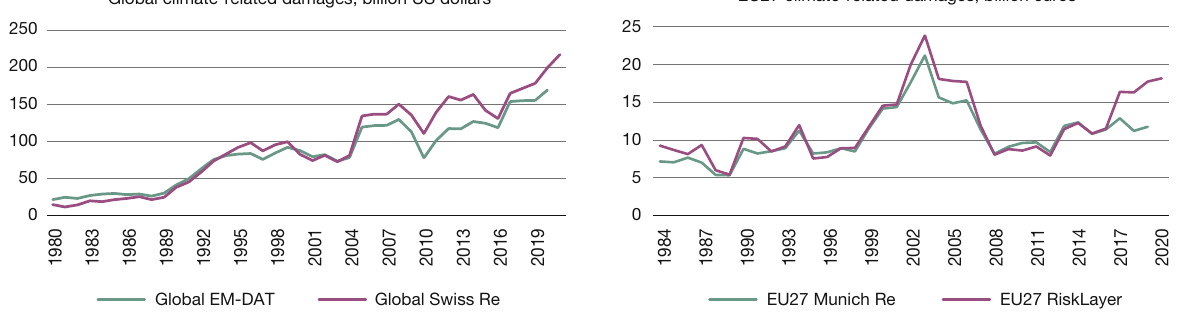
Sources: CRED/UCLouvain (2021), EM-DAT; Swiss Re Institute (2022); EEA